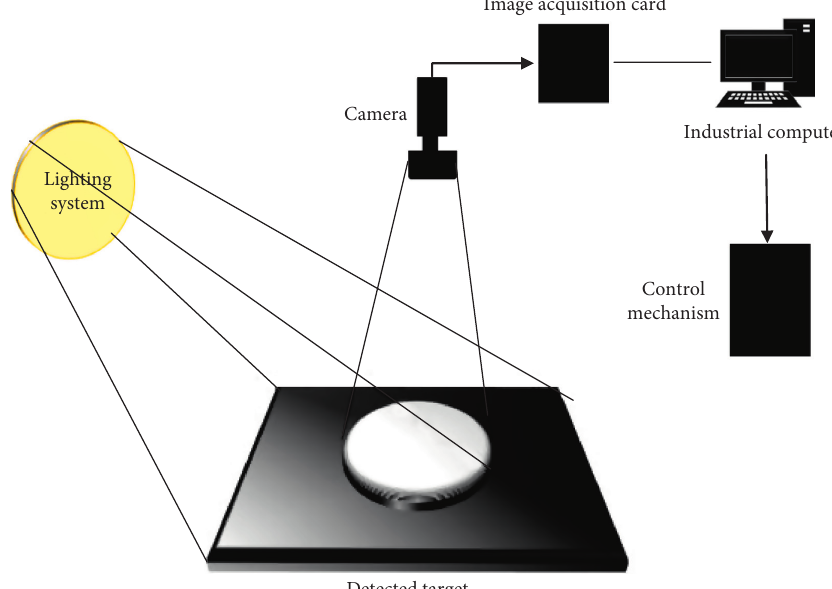
Figure 4: Structure diagram of a vision